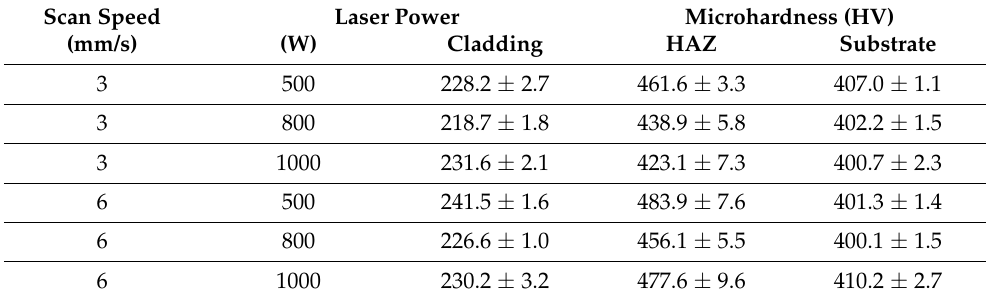
Table 4. Microhardness of cross-section on cladded substrates.